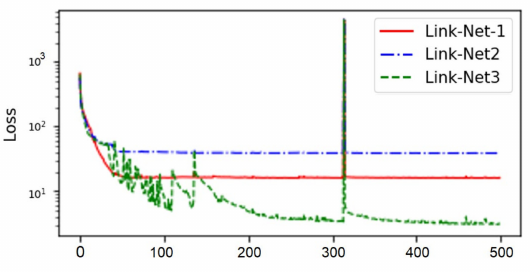
Figure 11. Loss history of all three links for 500 epochs with adaptive activation